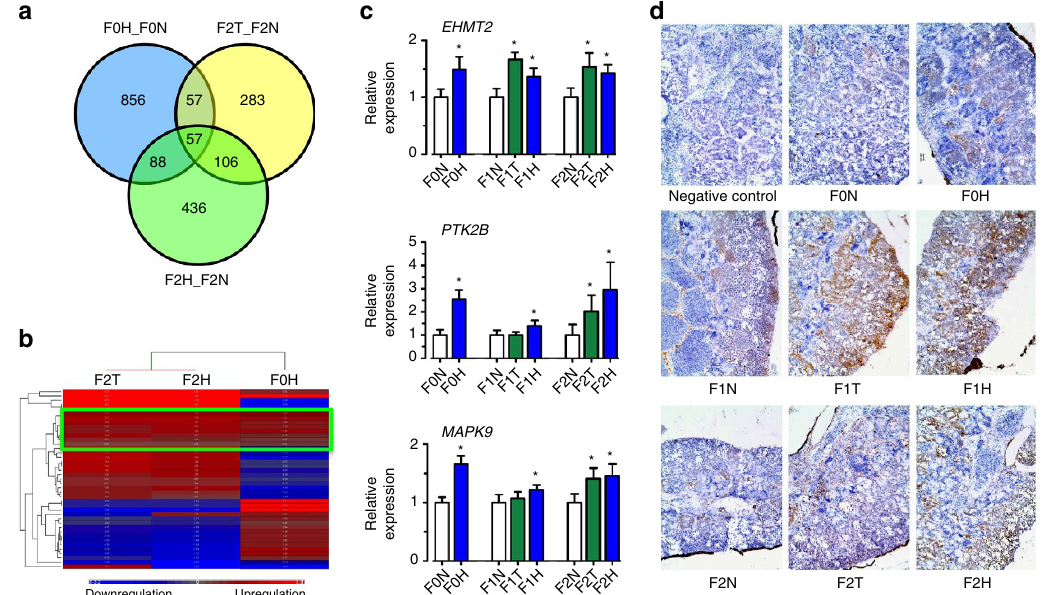
Figure 3 | EHMT2 dimethylated H3K9 found in the transgenerational group by RNA-Seq. ( a ) Venn diagram of the overlapping significant upregulated or downregulated genes shared among F0H_F0N, F2T_F2N and F2H_F2N ( n ¼ 6). ( b ) Clustering of 57 overlapping genes in F0H, F2Tand F2H. Red and blue bars represent upregulation and downregulation, respectively ( n ¼ 6). ( c ) Validation of the differential expression of euchromatic histone-lysine N-methyltransferase 2 ( EHMT2) , protein tyrosine kinase 2B ( PKT2B ) and mitogen-activated protein kinase 9 ( MAPK9 ) by qRT-PCR. Data are presented as the means ± s.e.m. * P o 0.05 ( n ¼ 10). ( d ) H3K9me2 abundance in testicular tissue as revealed by immunostaining. Positive signals are indicated by brownish colouring ( n ¼ 3).